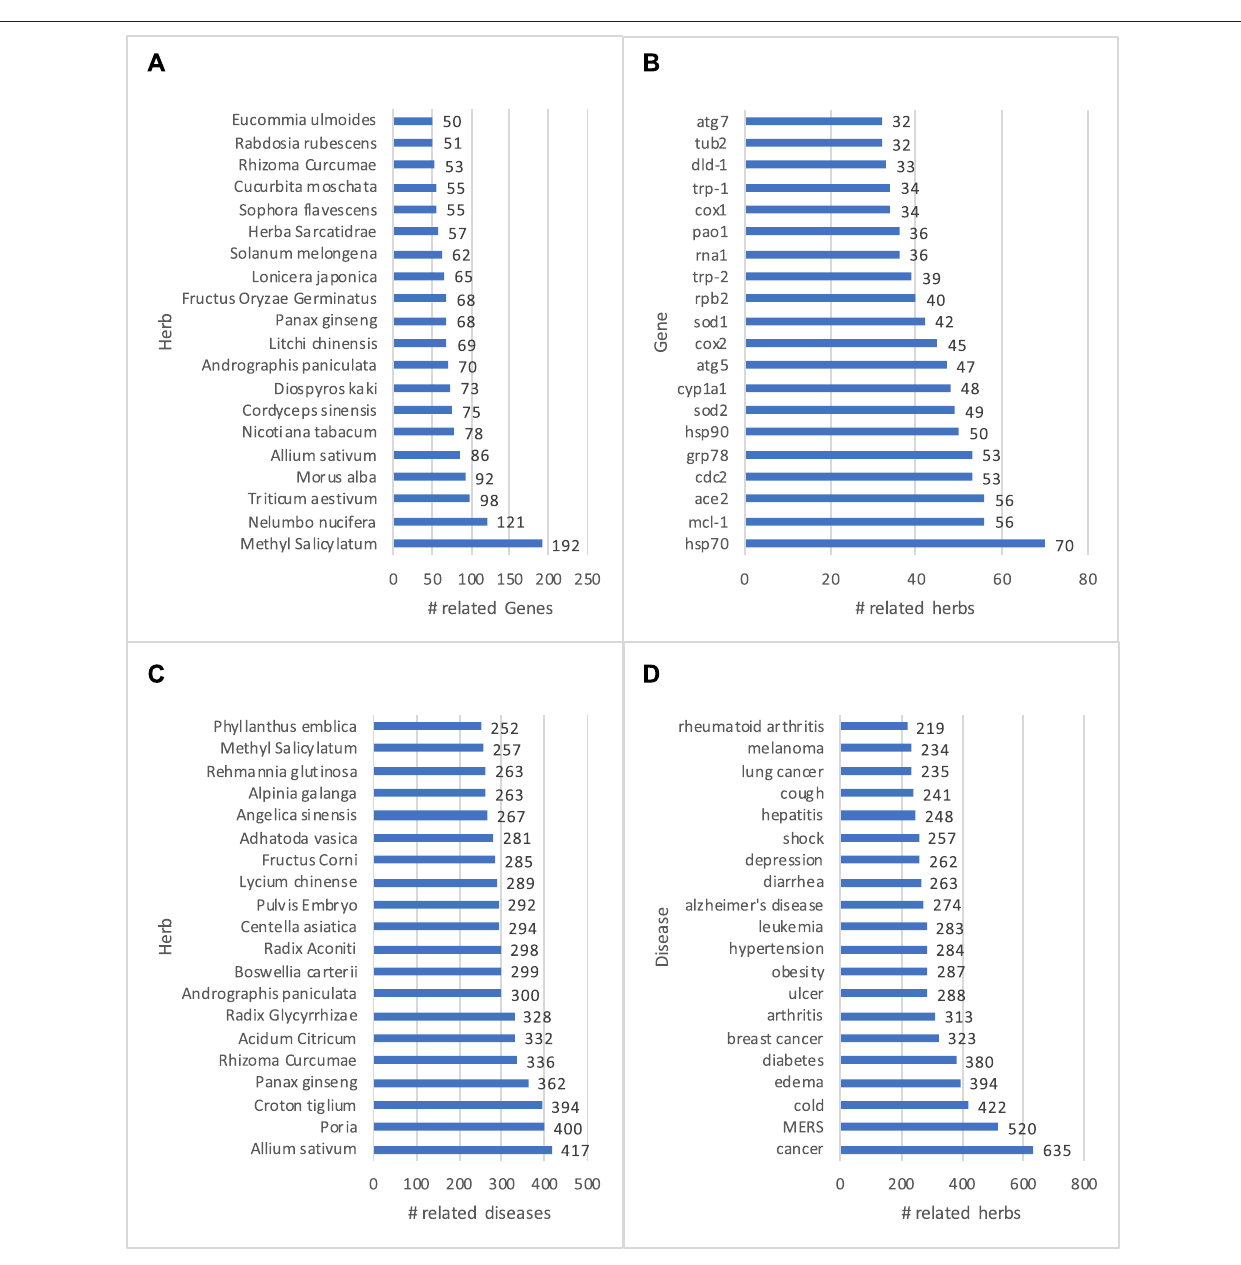
Frontiers in Genetics |